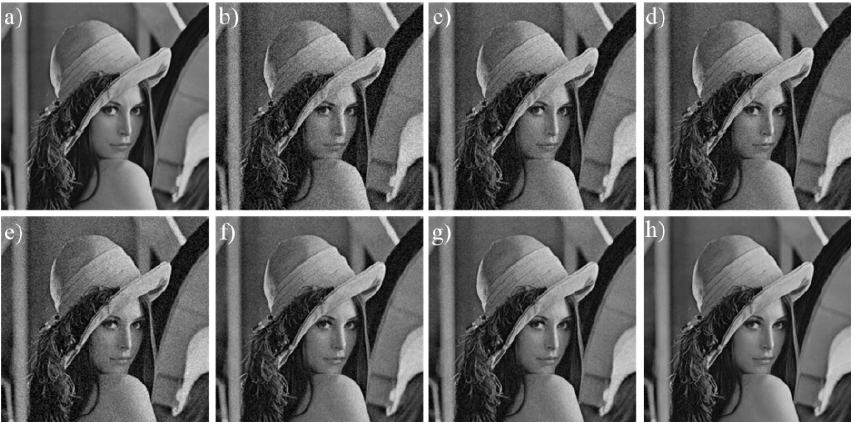
Figure 12. Recovery effect of the six methods to the Lena image. ( a ) original image; ( b ) noisy image; ( c ) orthogonal matching pursuit (OMP); ( d ) stage-wise OMP (StOMP); ( e ) basis pursuit(BP); ( f ) l 0 norm and gradient projection (L0GP); ( g ) l 0 norm and modified Newton method (L0MN); ( h ) L0RCD.